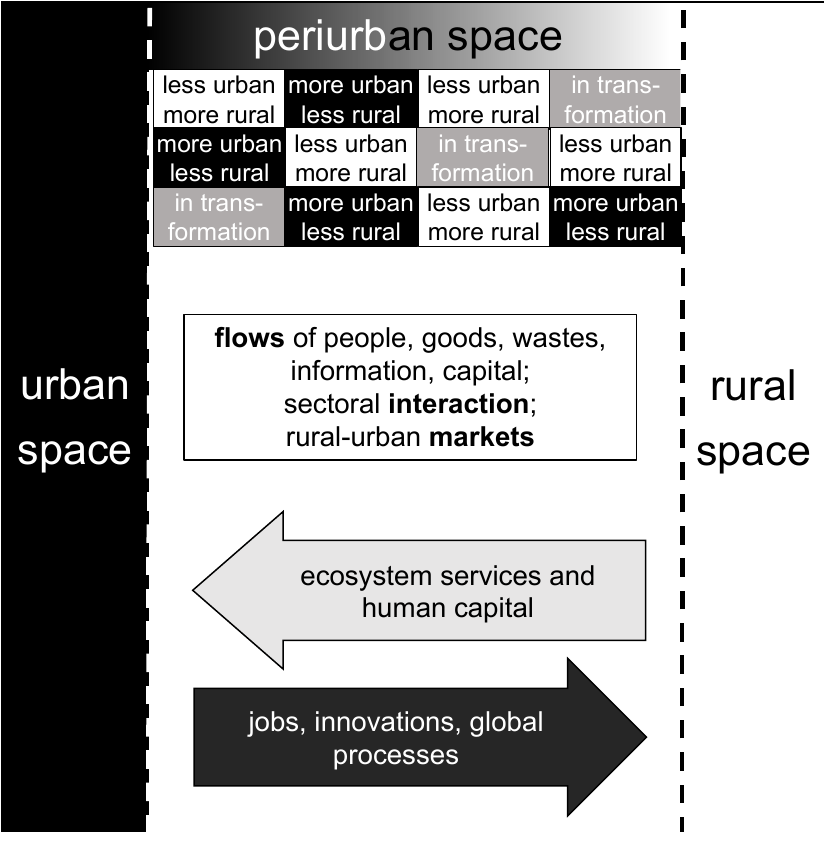
Figure 1. The periurban as a space in between.